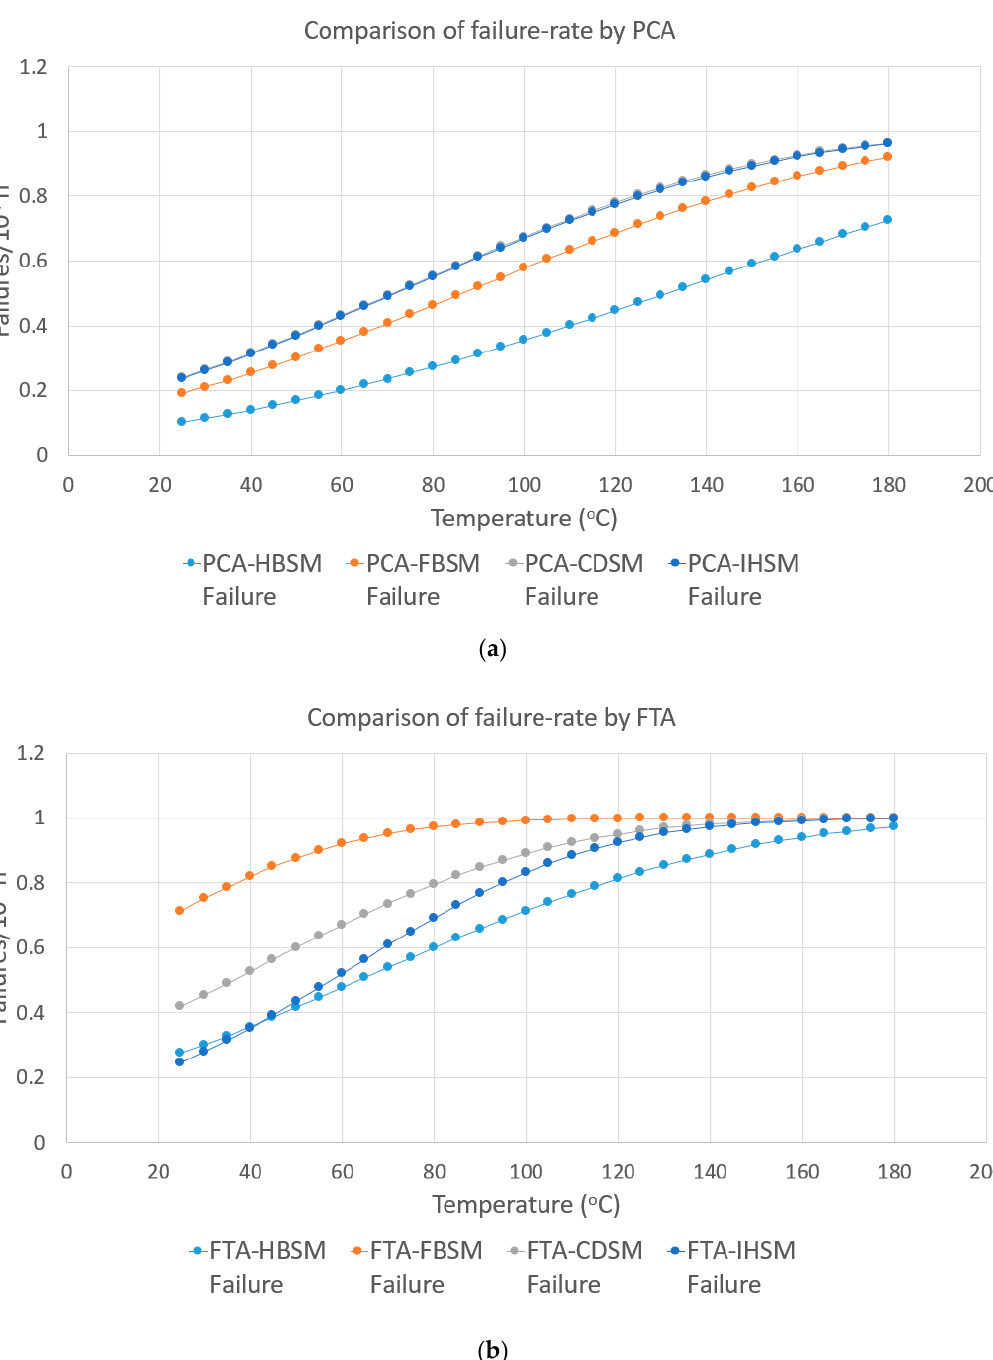
Figure 20. Comparison of failure rate and MTBF, ( a ) PCA-based, ( b ) fault-tree analysis (FTA)-based.